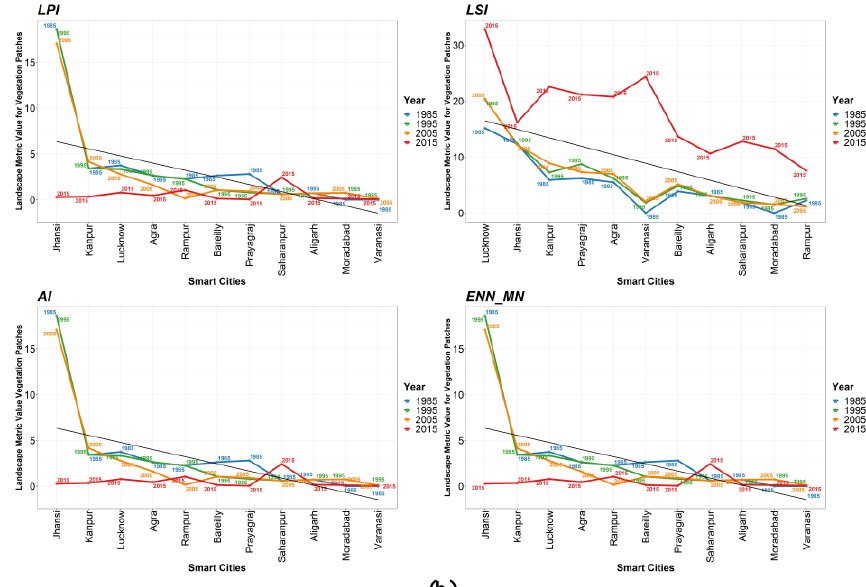
Figure 6. Landscape metric values of (a) built-up and (b) vegetation LU class across 11smart cities of Uttar Pradesh. Figure 6 best explains metrics values of each smart cities in both land use classes at individual level. Kanpur is the highest at all values except LSI for built-up patches, in which Lucknow the capital city of Uttar Pradesh is with the highest mean value for all years. Same is the case for lowest values of all metrics for built-up land use class except for LSI in which Rampur replaces Prayagraj having lowest in terms of LPI, AI and ENN_MN. The same trend follows in metric value plot for vegetation